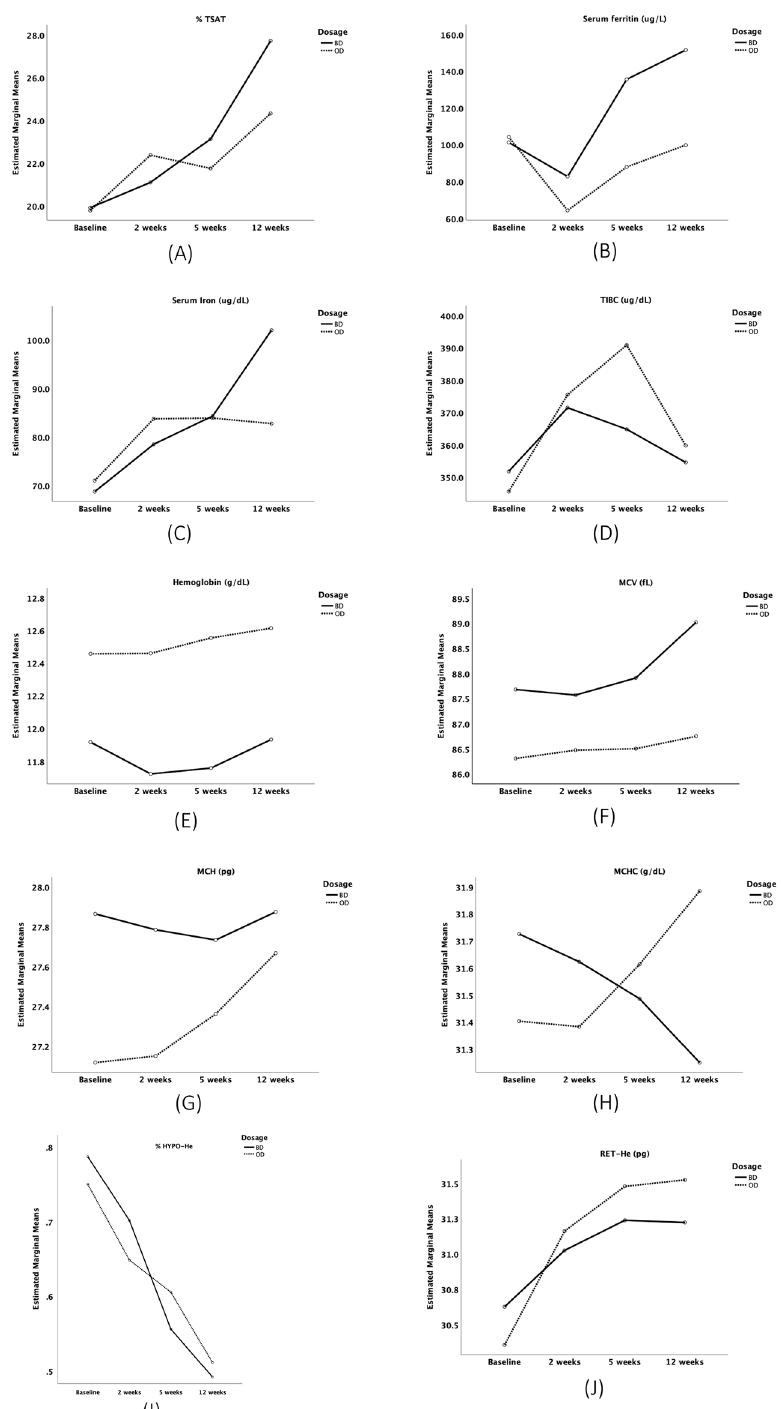
Figure 2. Change in estimated marginal means in the study groups. Trends for estimated marginal means for ( A ) %TSAT, ( B ) serum ferritin, ( C ) serum iron, ( D ) TIBC, ( E ) hemoglobin, ( F ) MCV ( G ) MCH, ( H ) MCHC, ( I ) % HYPO-He, ( J ) RET-He over 12 weeks. % HYPO-He percentage of hypochromic red blood cells, MCH mean corpuscular hemoglobin, MCHC mean corpuscular hemoglobin concentration, MCV mean corpuscular volume, RET-He reticulocyte hemoglobin equivalent, TIBC total iron binding capacity, % TSAT percentage transferrin